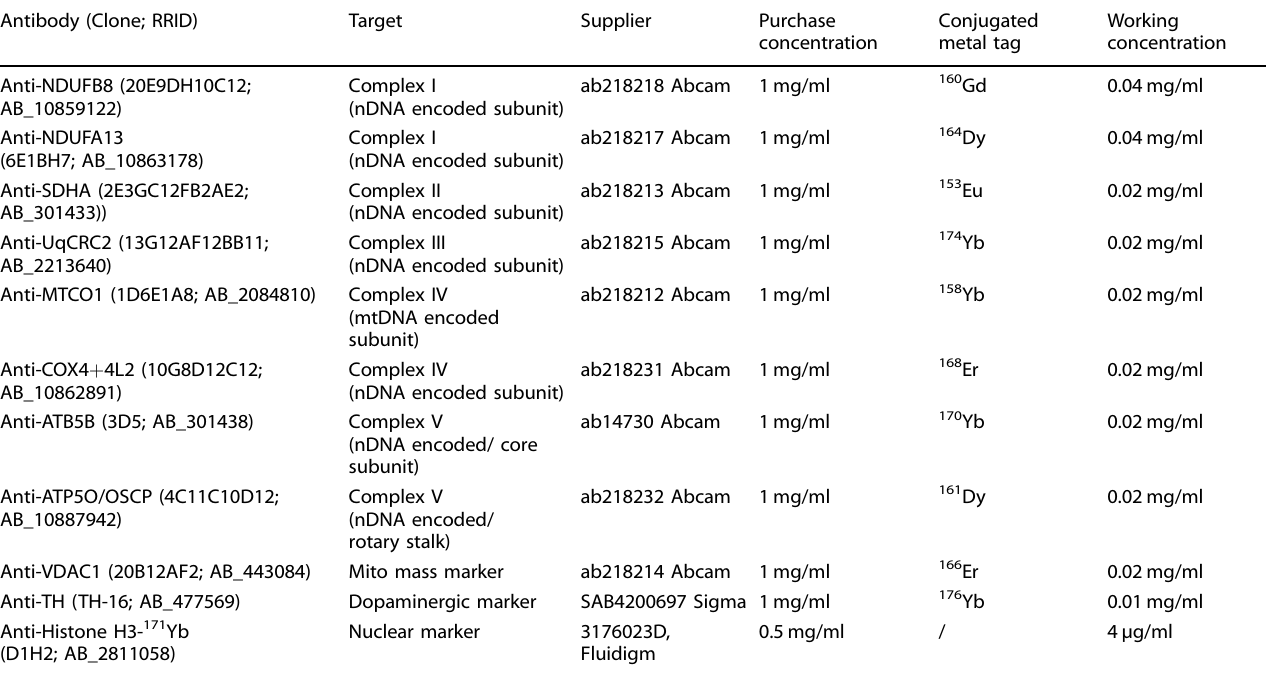
Table 1. IMC antibody panel for this